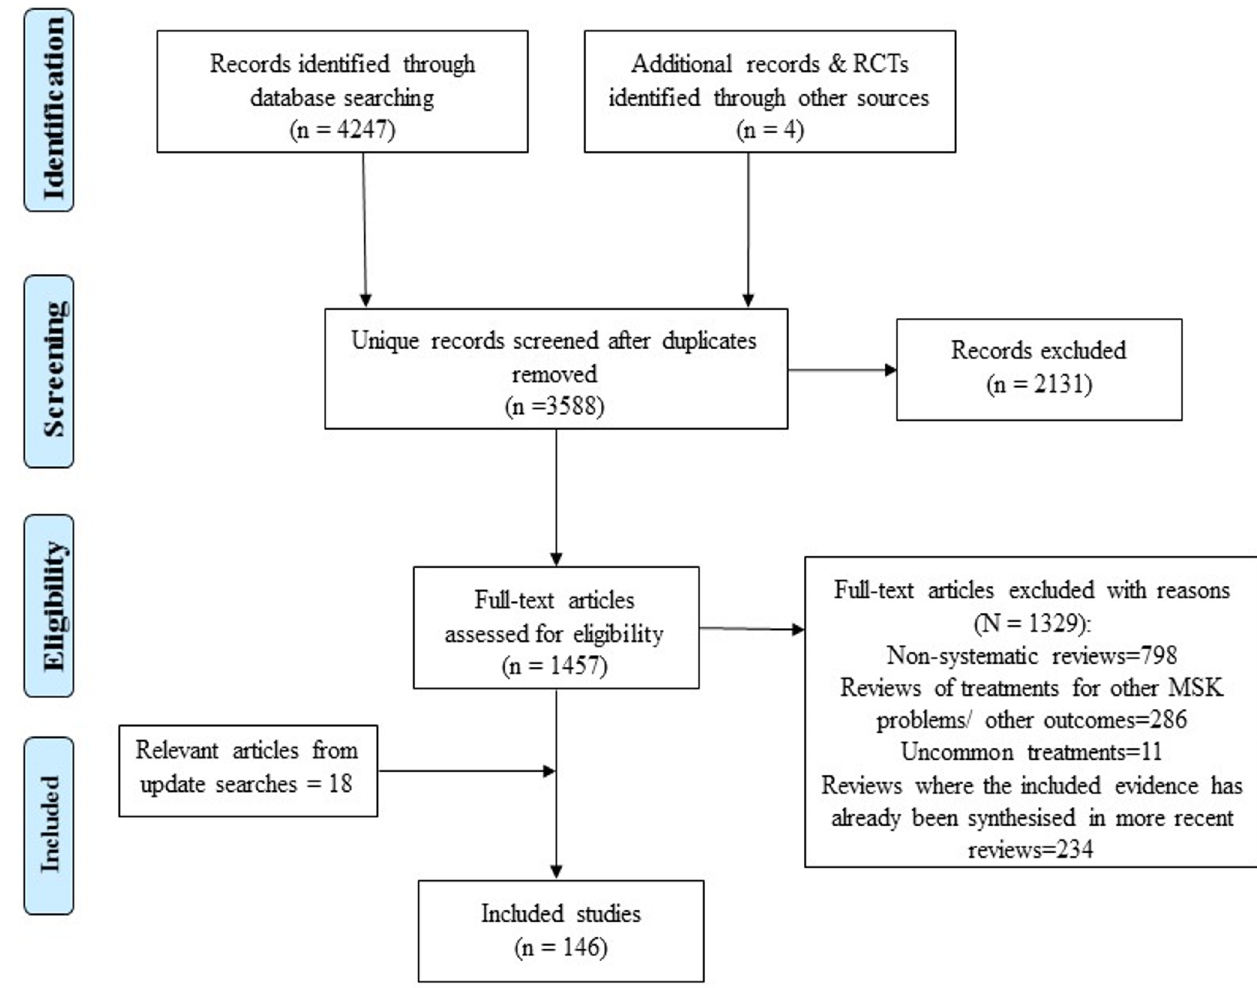
Fig 1. Review flow diagram